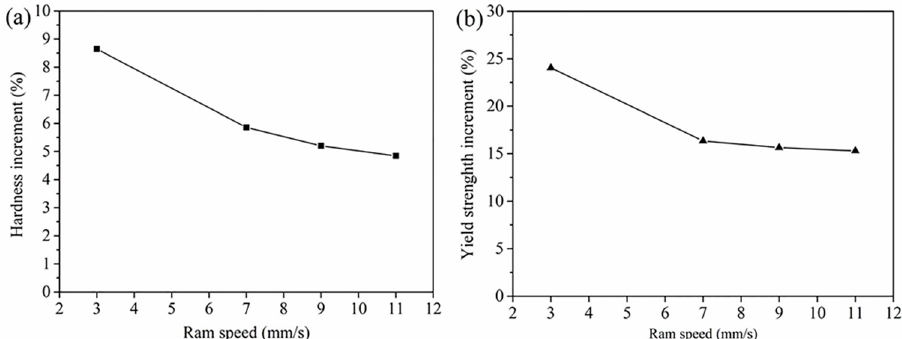
Figure 14. Increments of mechanical properties due to smaller grain sizes in the matrix zones: ( a ) microhardness increment; ( b ) yield strength increment.